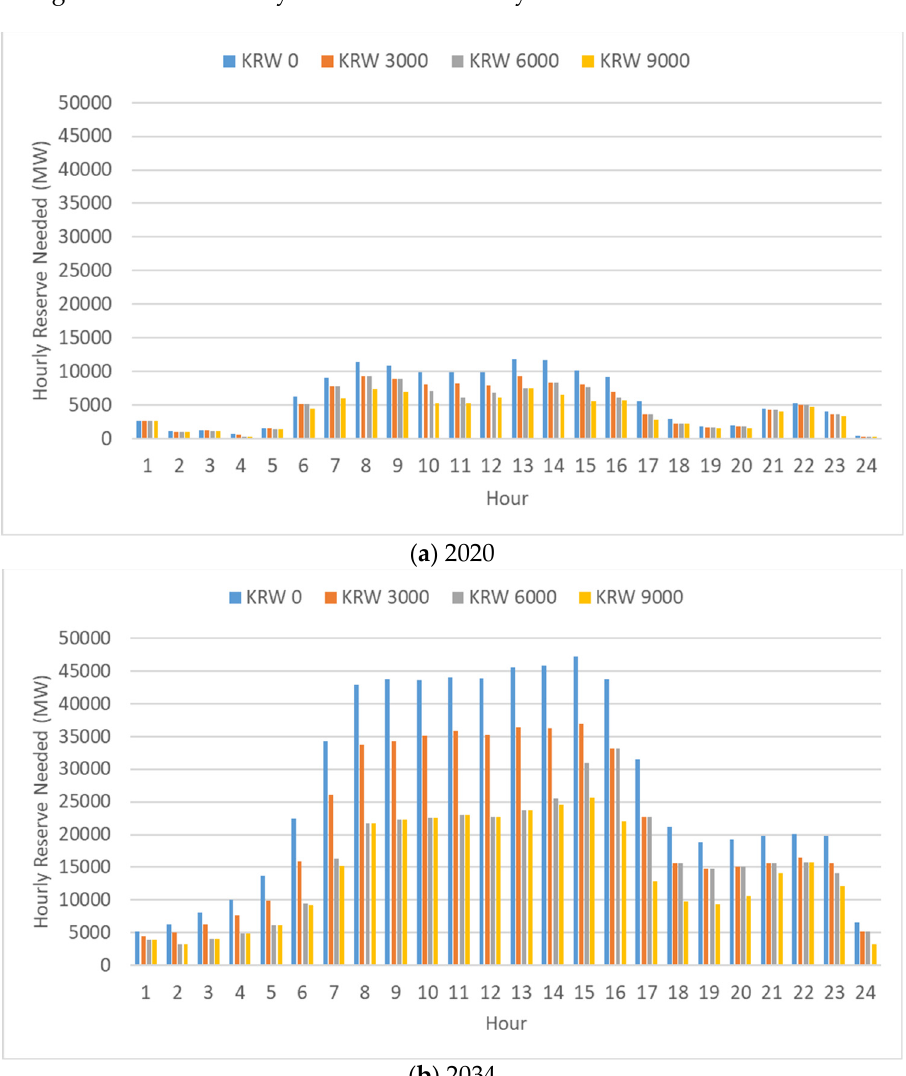
Figure 5. Hourly reserve needed considering varying reserve offer prices, 2020 vs. 2034.